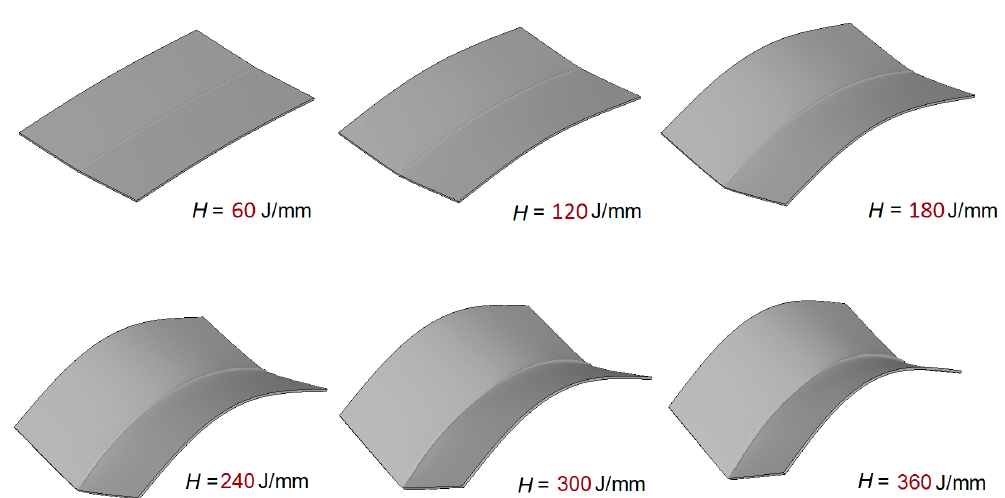
Figure 17. Welding distortion under various heat input condition (scale factor is 10).